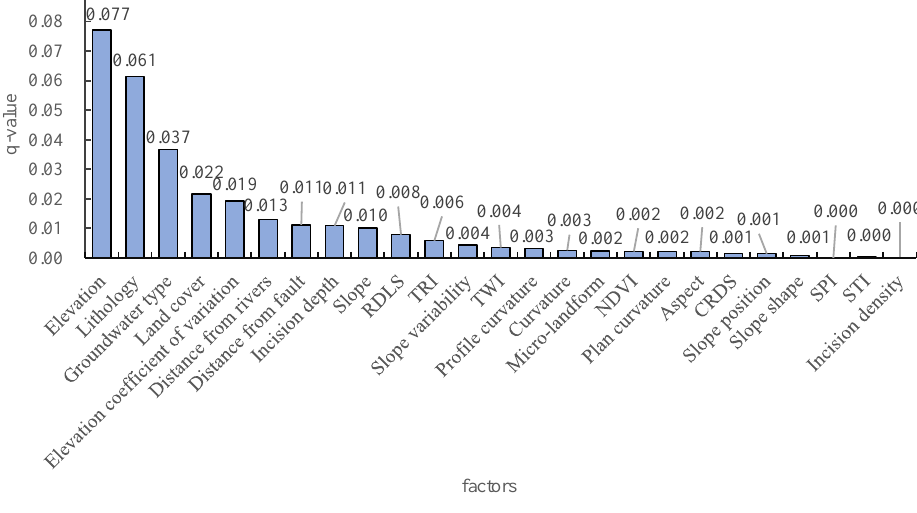
Figure 10. Factor detector results.